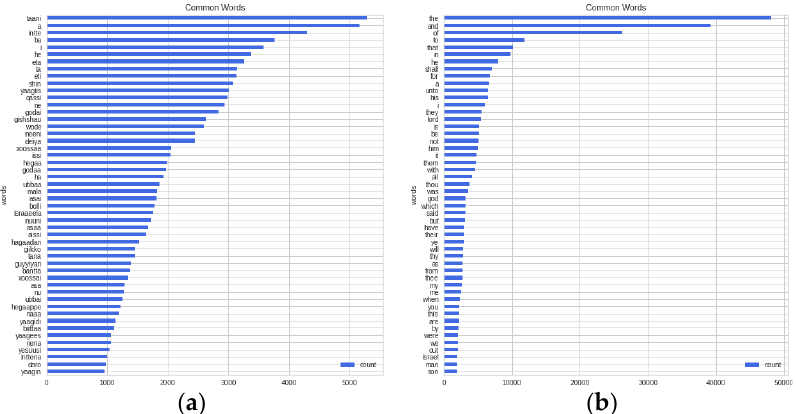
Figure 1. Fifty most common words in the parallel corpora. ( a ) Wolaytta parallel data; ( b ) English parallel data.